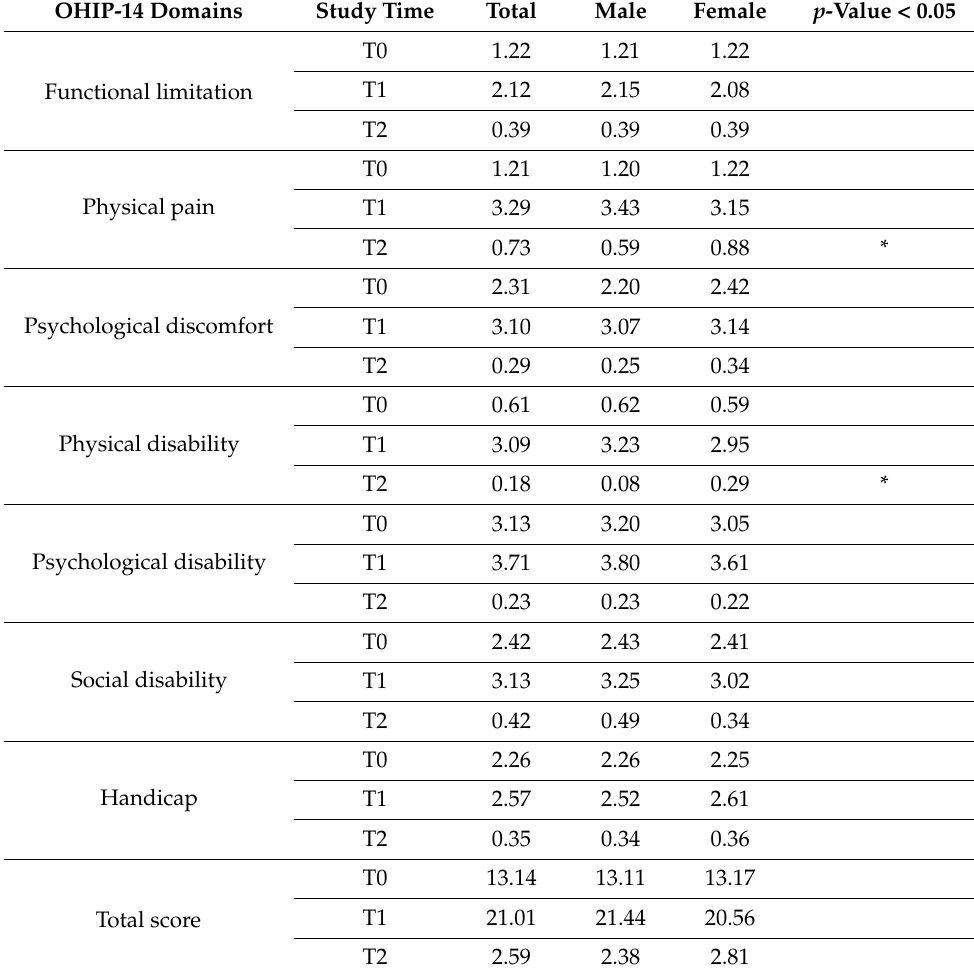
Table 4. Comparison between means in OHIP-14 scores for the four types of orthodontic treatment at three study times (T0, T1, and T2).